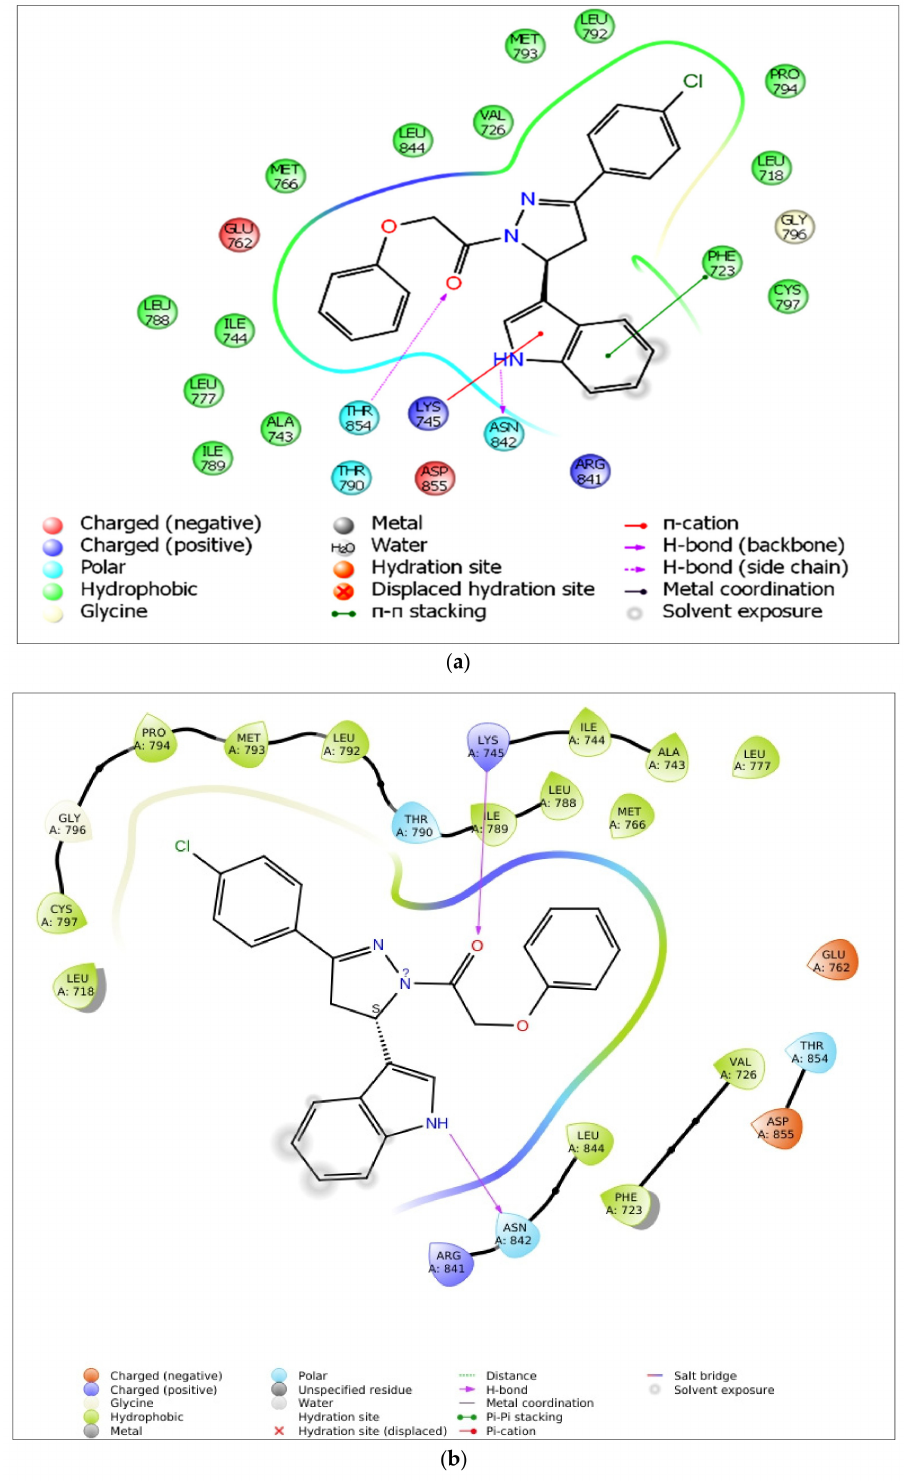
Figure 2. Ligand binding: 2D overlay of the compound HD05 with the active site of EGFR-TK. The binding of HD05 to the active site of the EGFR-TK protein, and the hydrogen binding sites are shown in ( a , b